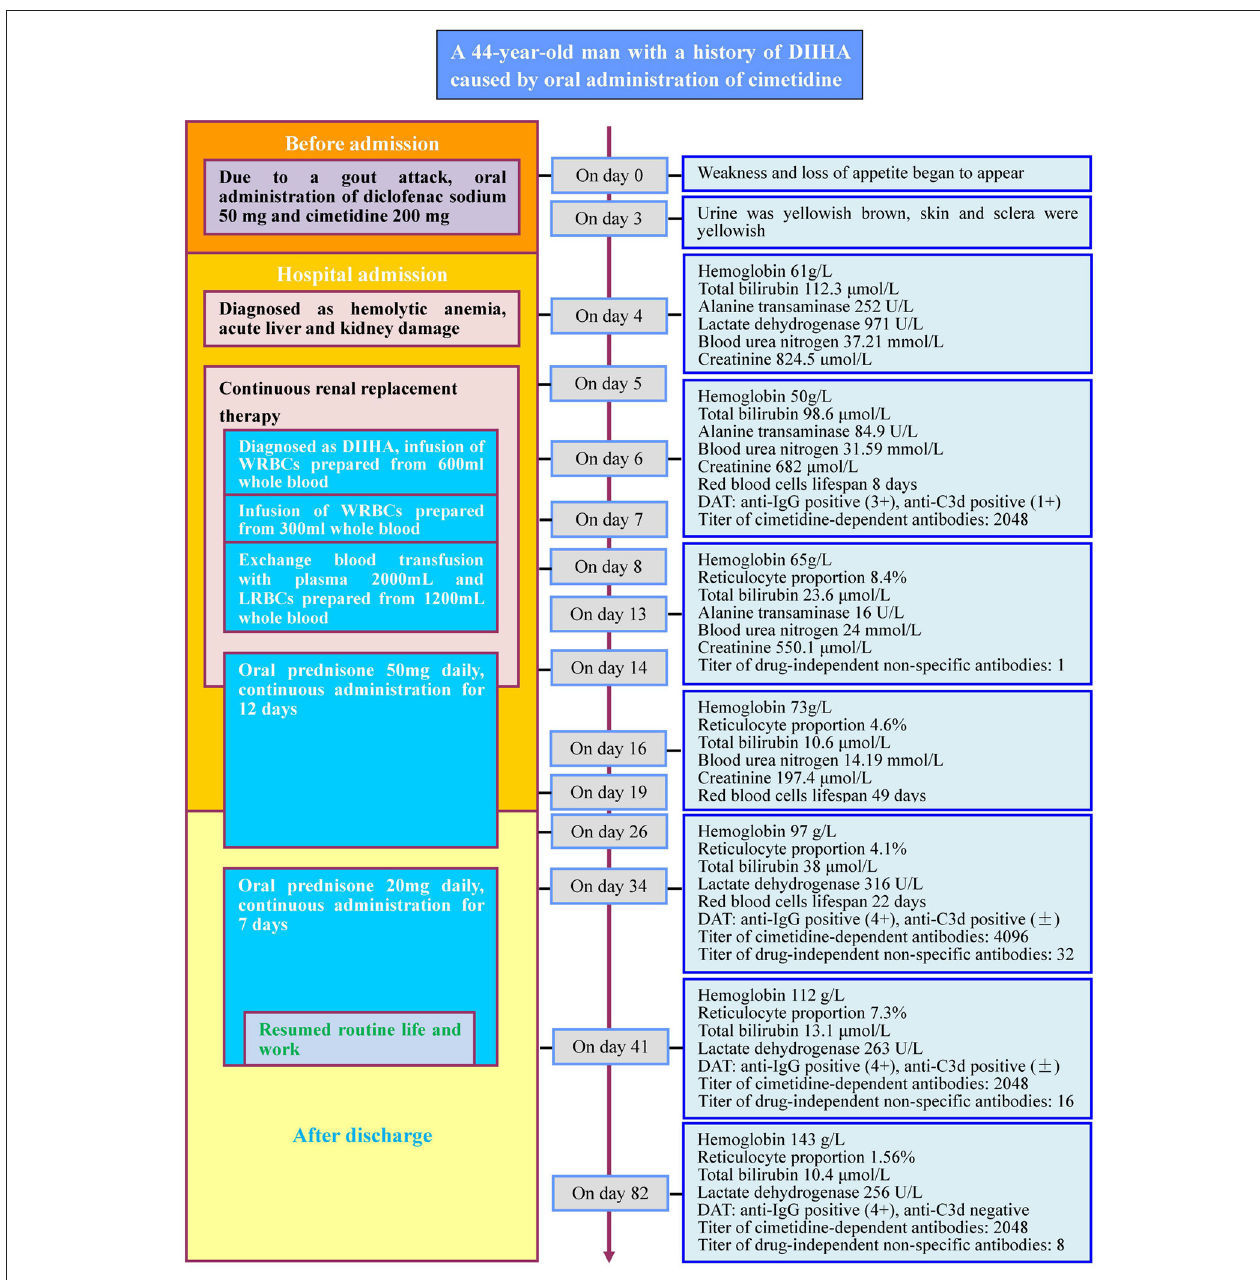
FIGURE 1 | Case report timeline. DIIHA, drug-induced immune hemolytic anemia; WRBCs, washed red blood cells; LRBCs, leukocyte-reduced red blood cells. + , strong; ± , slightly strong. Red blood cells lifespan: the average survival time of red blood cells measured by using the open-breath CO breath test.